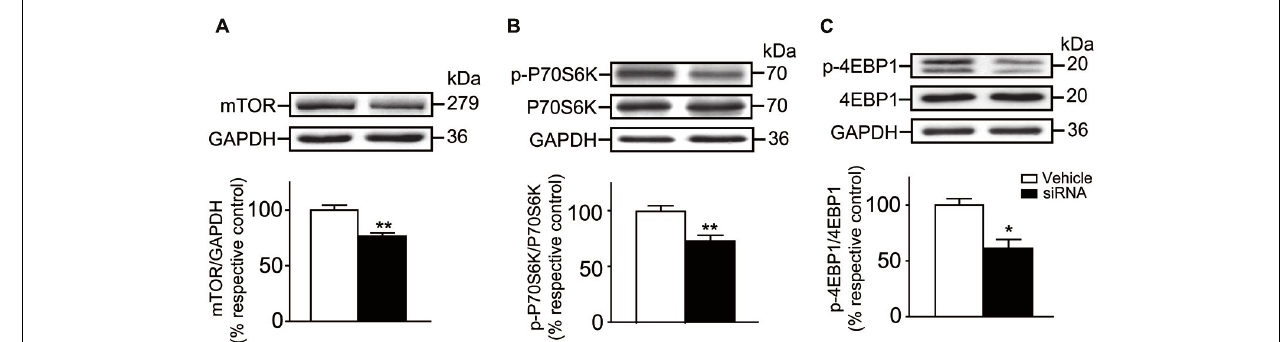
FIGURE 7 | mTOR siRNA infusion inhibited striatal mTOR expression and decreased the levels of phosphorylated P70S6K and 4EBP1. (A) Levels of total striatal mTOR were evaluated by western blot after the infusion of vehicle (distillated/deionized water DNase/RNase free) or mTOR siRNA.The data, expressed relative to GAPDH, represent the mean of relative optical density of total mTOR (expressed as a percentage of control values) ± S.E.M, n = 3–4; triplicate experiments for each mouse/group. ** P < 0.01 vs.